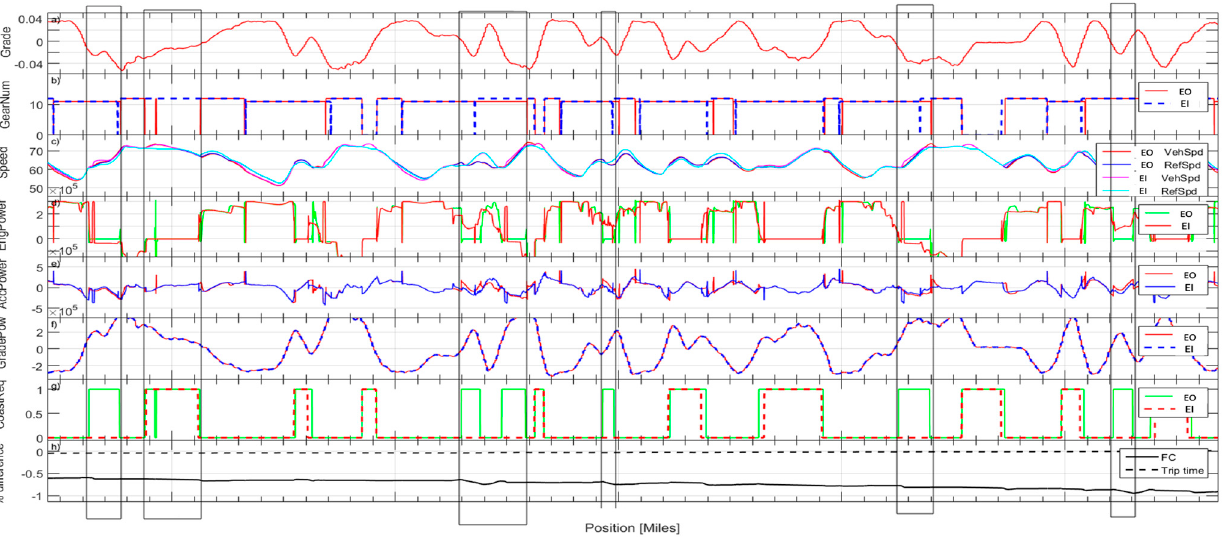
Figure 5. Performance results for optimal solution compared to baseline rule based control. The plot is a zoomed version of a stitched version of different sections in the route. is a zoomed version of a stitched version of different sections in the